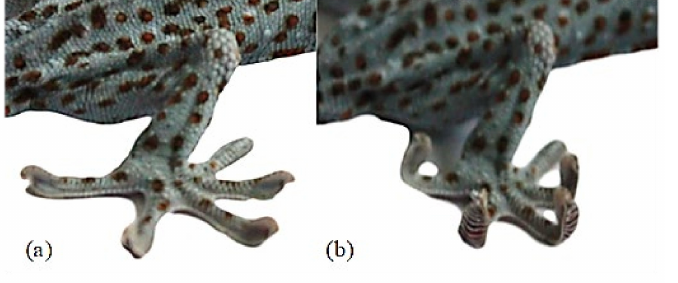
Figure 10. The desorption method of a gecko foot: ( a ) The gecko’s foot is spread out; ( b ) the gecko’s foot is curled up.